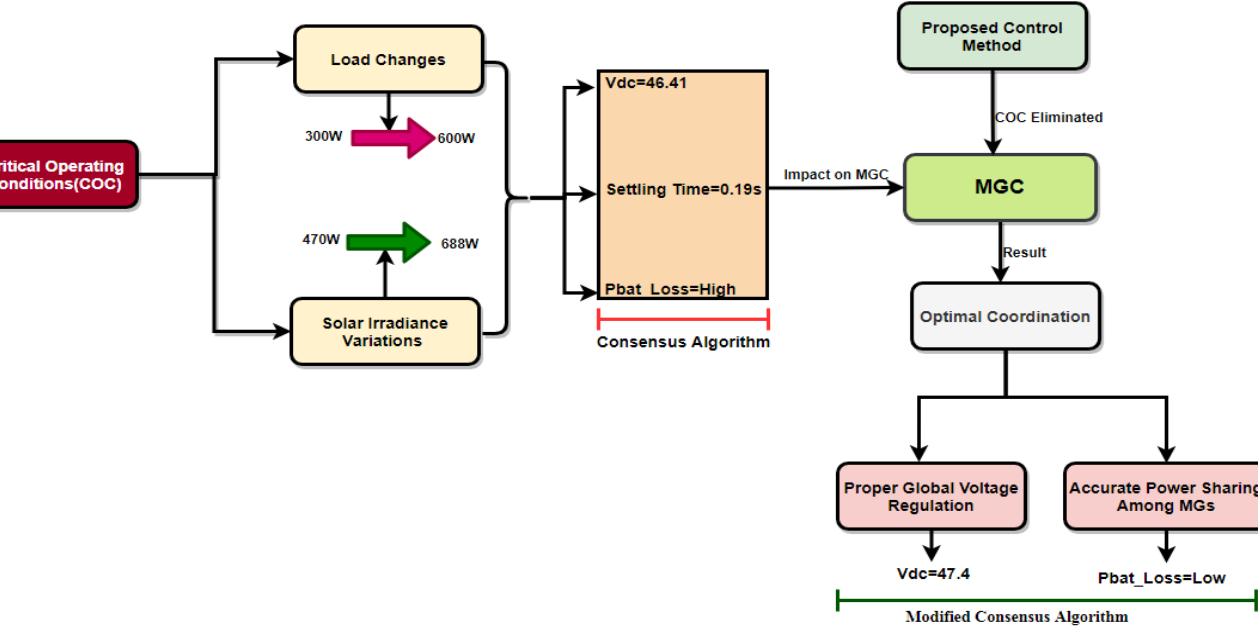
Figure 12. Summary of the main results.